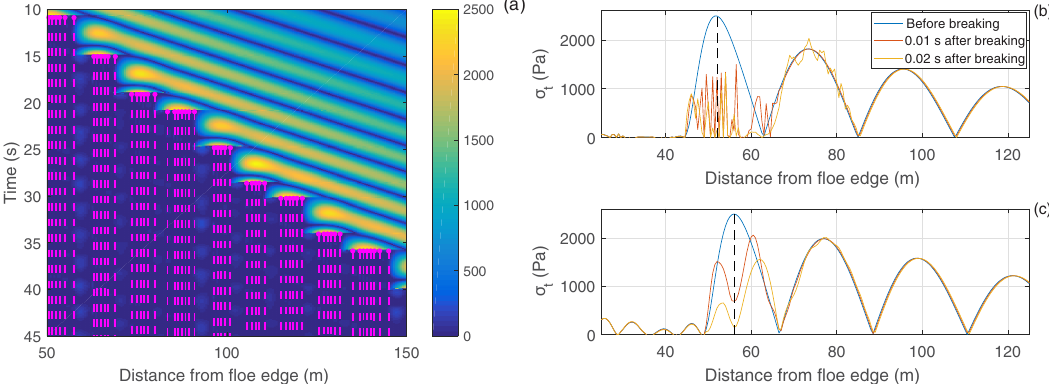
Figure 11. Comparison of the model behavior in simulations with instantaneous and “delayed” bond breaking: space–time variability of the tensile stress σ t (Pa) in a simulation analogous to that shown in Fig. 8 but with instantaneous bond breaking (a) ; and details of σ t in the vicinity of a selected breaking event from a simulation with instantaneous (b) and “delayed” (c) bond breaking. The curves in panels (b, c) show σ t along a selected fragment of the ice floe before (blue) and shortly after (red and yellow) breaking; dashed black lines mark the location where breaking took